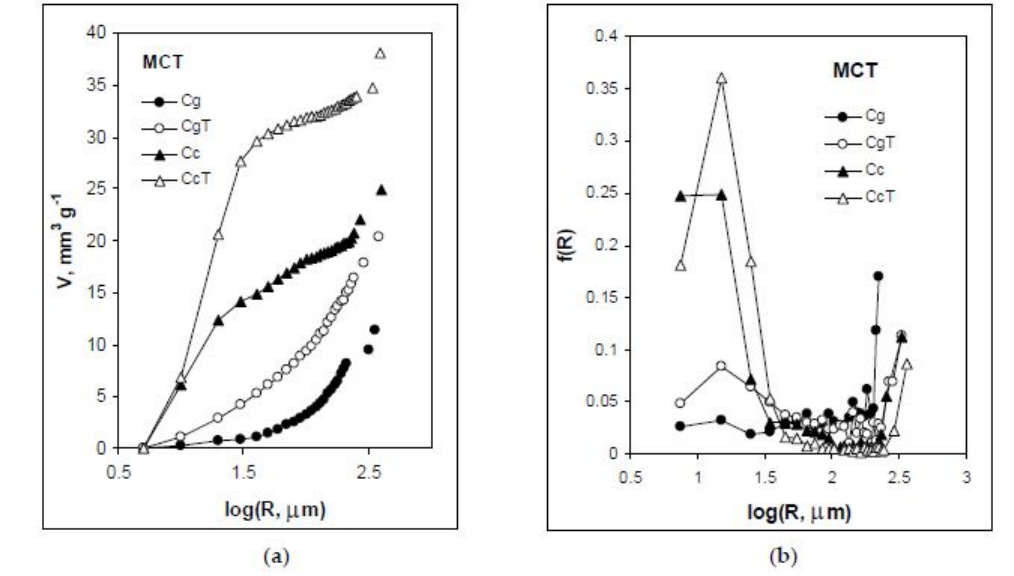
Figure 3. Microtomography (MCT) pore volume vs. pore radius curves ( a ) and pore size distribution functions ( b ) for the studied concretes. Abbreviations: c–ceramics, g–granite, C–concrete and T–heated.